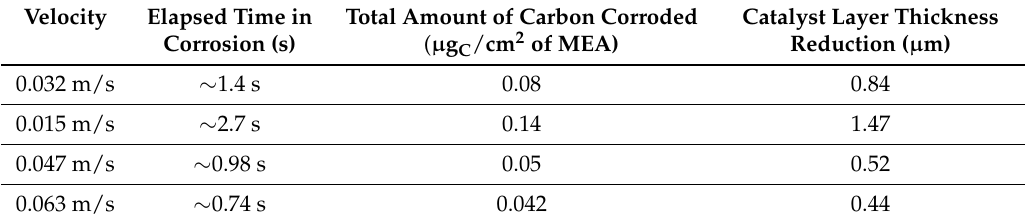
Figure 7. Cell potential ( a ) and cathode electrode potential ( b ) at the cathode inlet during a startup for different H 2 velocities. Table 3. Elapsed time in corrosion and total amount of carbon corroded for the different velocities.